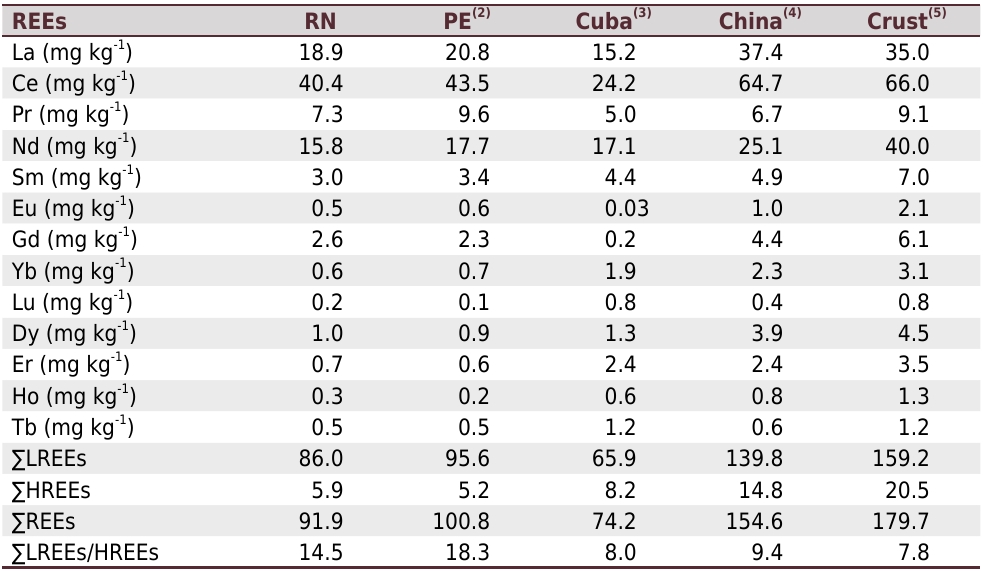
Table 1. Mean contents of rare earth elements (REEs) in the soils of Rio Grande do Norte, Brazil, compared to data from Pernambuco, Brazil, other countries, and the Earth’s crust